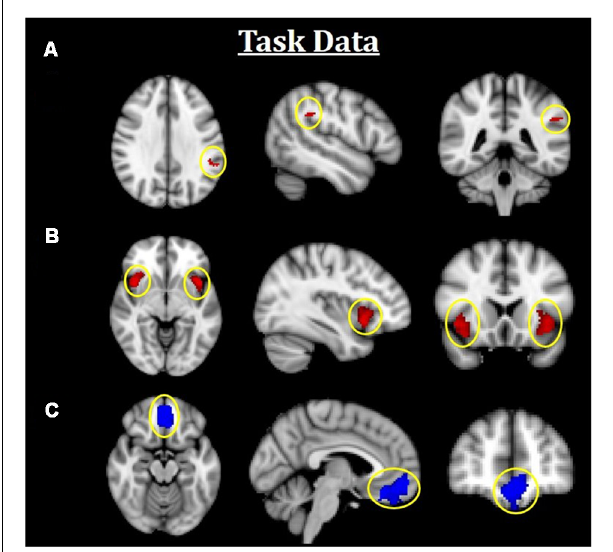
FIGURE 3 | Neuroimaging task results. All results are family-wise error (FWE)-corrected, p < 0.05. Red indicates Fearful > Neutral (F > N) faces and blue indicates Neutral > Fearful (N > F) faces. (A) Greater left TPJ activation was related to F > N. (B) Greater bilateral insula activations related to F > N. (C) Increased mPFC activation was related to N > F. TPJ, temporoparietal junction; mPFC, medial prefrontal